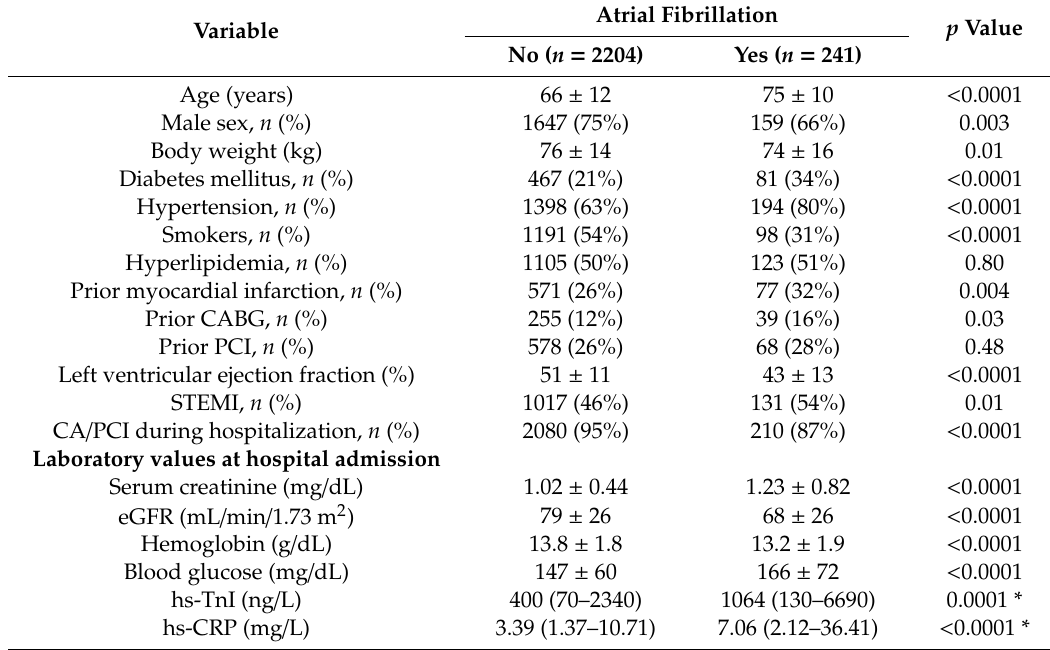
Table 1. Baseline characteristics and in-hospital complications of the study patients according to the occurrence of atrial